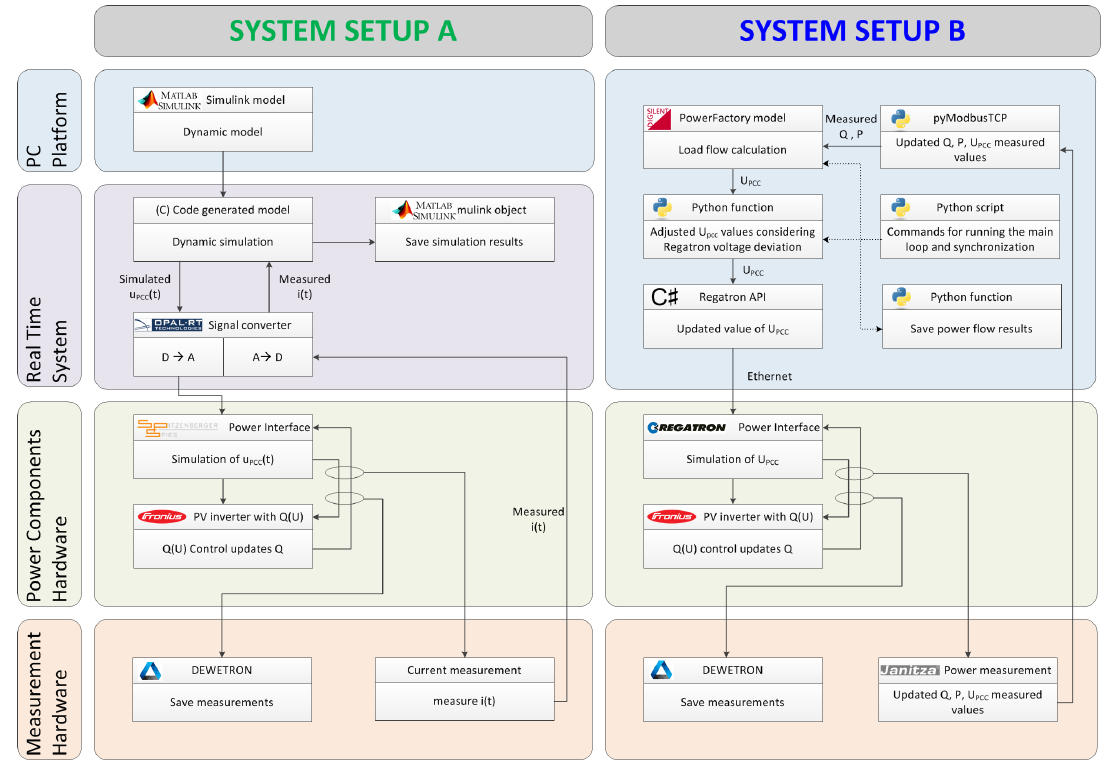
Figure 4. Comparison of the architecture of the used system setups: System Setup A is an Opal-RT RT-LAB based system with Spitzenberger Spies PAS and System Setup B is a Digsilent PowerFactory based system with Regatron